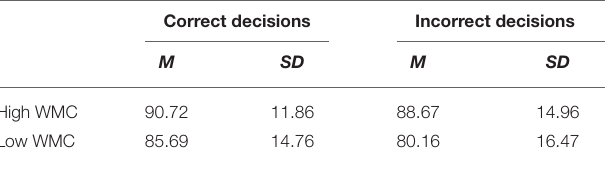
TABLE 6 | Mean confidence in correct word recall for correct and incorrect true/false decisions for high and low WMC participants.